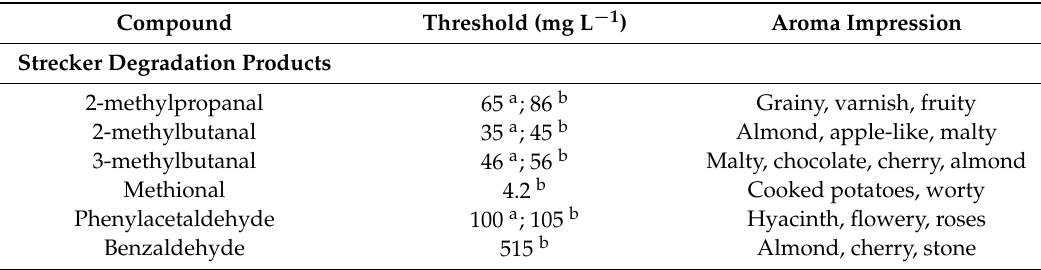
Table 3. Threshold values and aroma impression of most important Strecker Degradation products present in